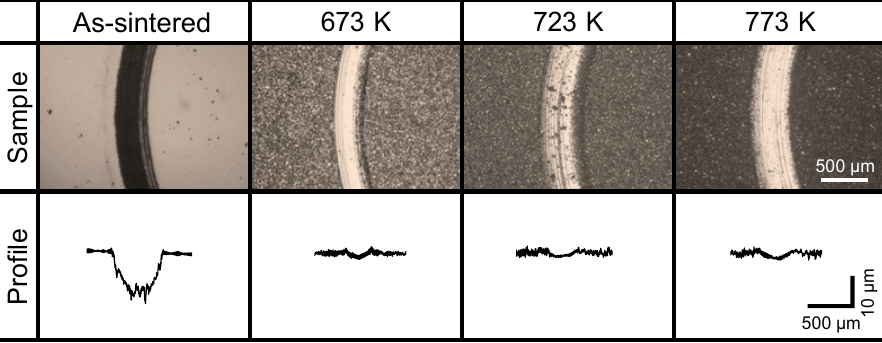
Figure 12. Friction coefficient of plasma-nitrided CoCrFeMnNi samples during wear tests.